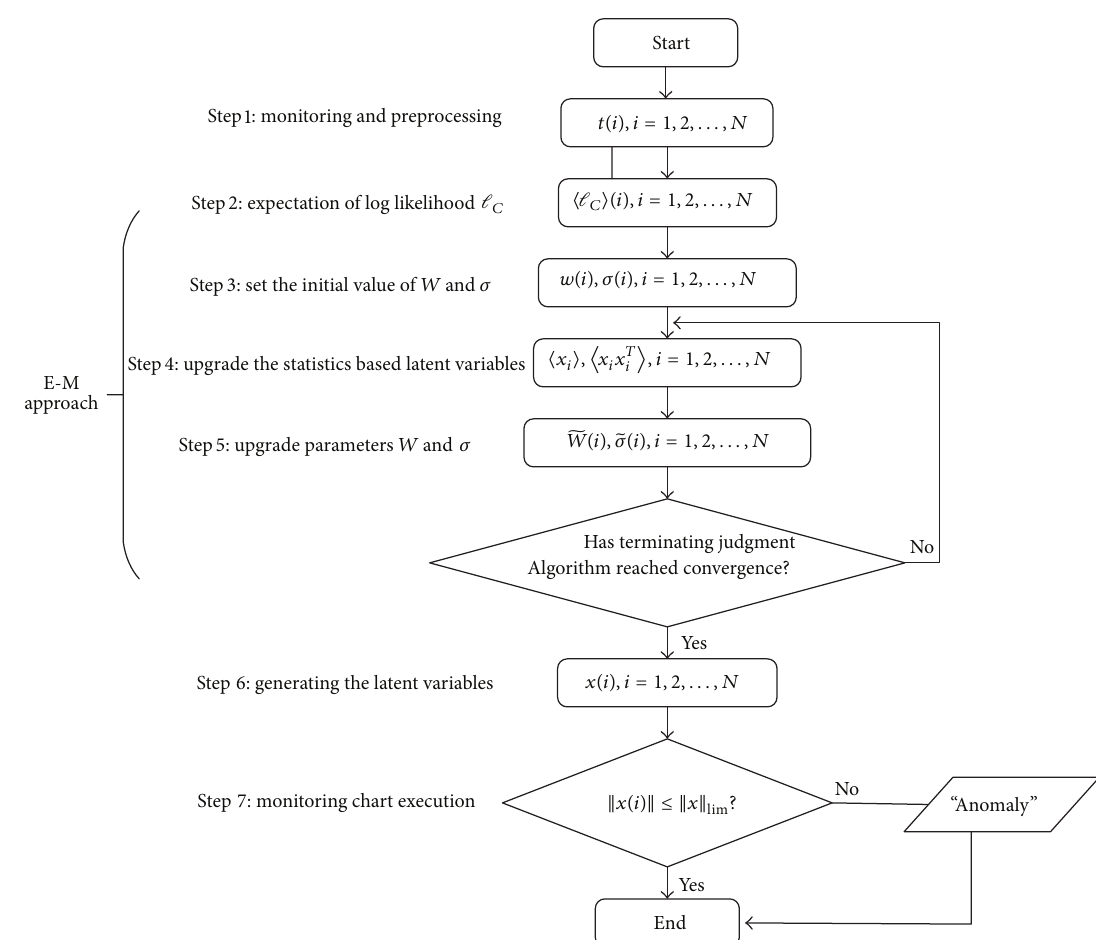
Figure2:Real-timecalculationatthetimestep 𝑘 ofprobabilisticprincipalcomponentanalysis(PPCA)—monitoringchartdetectionmethod.